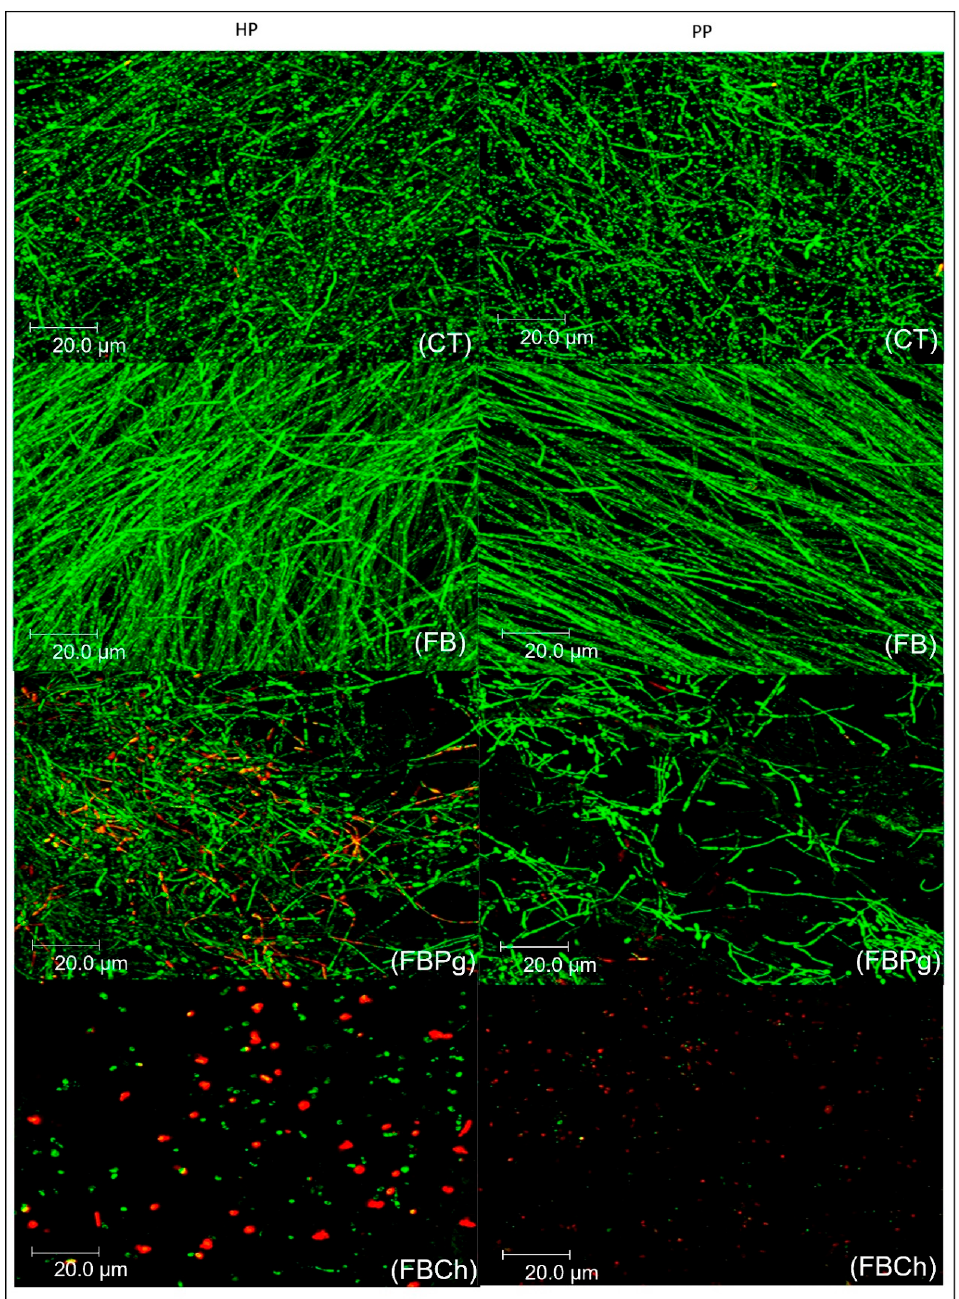
Figure 3. Confocal images of C. albicans biofilms developed on heat-polymerized (HP) and pre-polymerized (PP) surfaces after 72 h of incubation. CT: control group; FB: Fibrin biopolymer; FBPg: P. granatum incorporated in fibrin biopolymer; FBCh: Chlorhexidine incorporated in fibrin biopolymer.